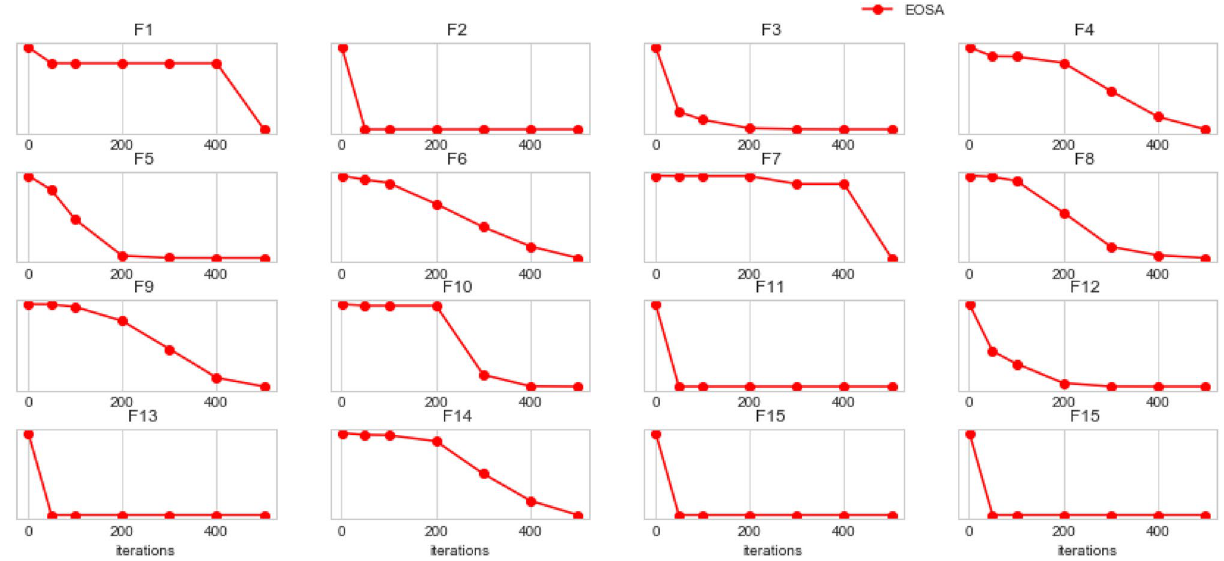
Figure 5. Convergent curves of EOSA optimization algorithm on F1, F2, F3, F4, F5, F6, F7, F8, F9, F10, F11, F12, F13, F14 and F15 standard benchmark